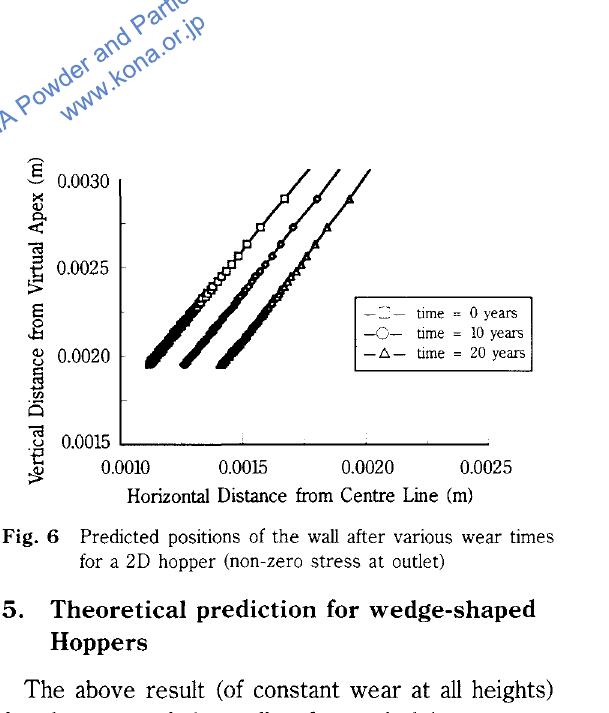
Fig. 7 The differential slice used to obtain eqn. 3 showing the forces and stresses acting on the element.